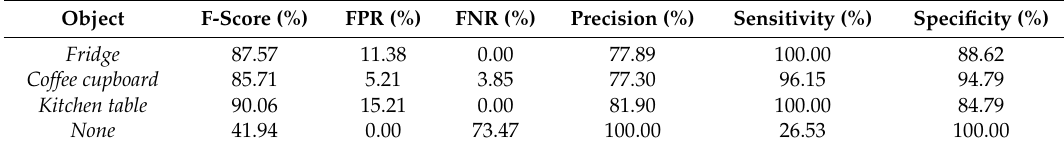
Table 8. Results for the calculations of the proximity detection for any given